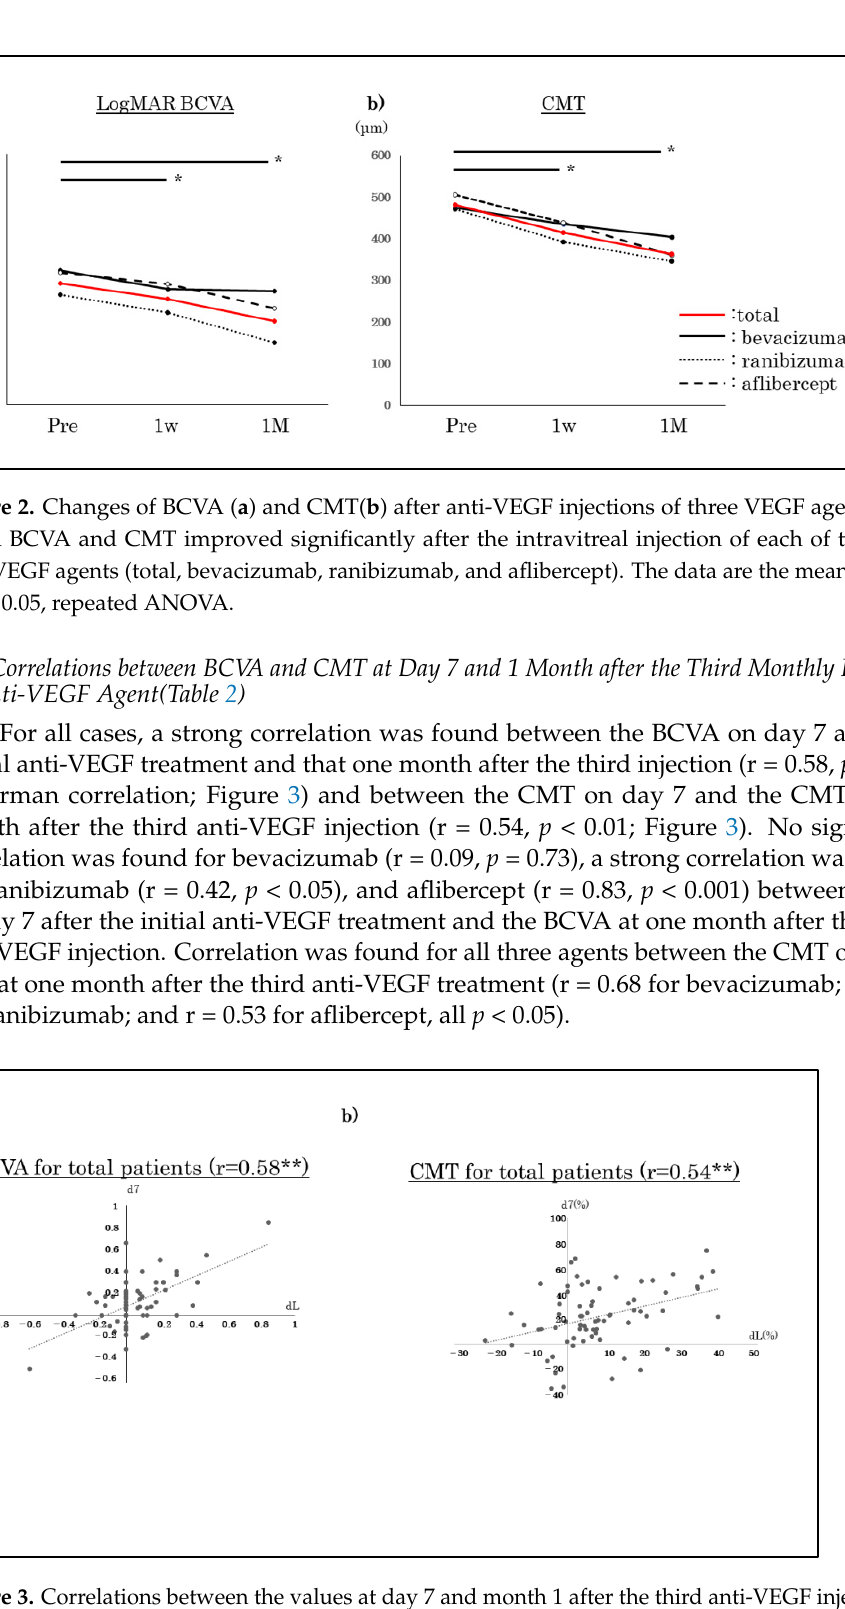
Figure 3. Correlations between the values at day 7 and month 1 after the third anti-VEGF injection. A moderate correlation can be seen between the BCVA at day 7 and one month after the third injection for all cases ( a , r = 0.58; p < 0.01; Pearson correlation coefficient). A moderate correlation can be seen between the CMT on day 7 and one month after the third anti-VEGF injection ( b , r = 0.54; p < 0.01). **: p < 0.01, Spearman’s rank-order correlation